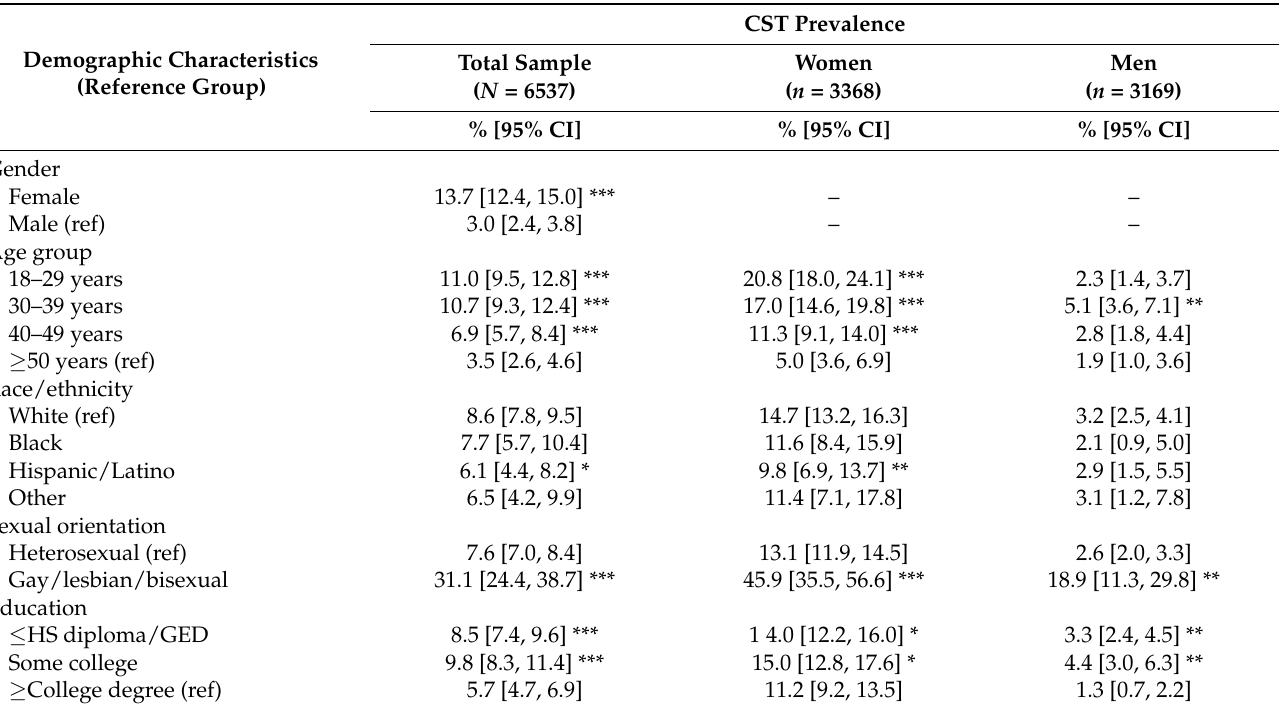
Table 3. CST prevalence: Total sample and demographic sub-groups (National Sexual Health Survey, 1996) †